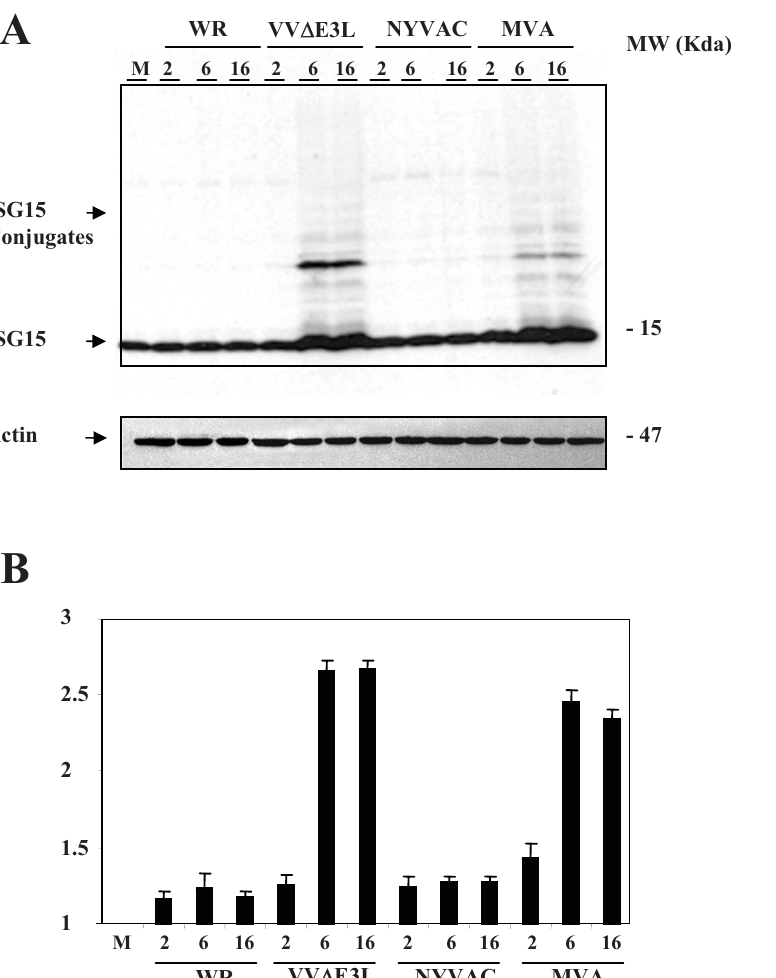
Figure 1. ISG15 protein levels are upregulated during infection of MEFs with the attenuated mutants of vaccinia virus. A . ISG15 protein levels after WR or VV D E3L or MVA or NYVAC infection. MEFs were mock infected (M) or infected at 5 PFU/cell with WR or MVA or NYVAC or VV D E3L and at the indicated times p.i, cell extracts were analyzed by Western blotting. Equal amounts of proteins were fractionated by SDS-PAGE, transferred to nitrocellulose paper, and reacted with an antibody that recognizes murine ISG15 protein. On the right, the molecular weight of the proteins in kilodaltons is indicated. Actin levels showed that the same amount of protein was loaded on the gel. Uninfected cells (M) served as control. B . Densitometric quantification of ISG15 protein in arbitrary units is indicated. The graphic represents these measurements in three independent experiments.